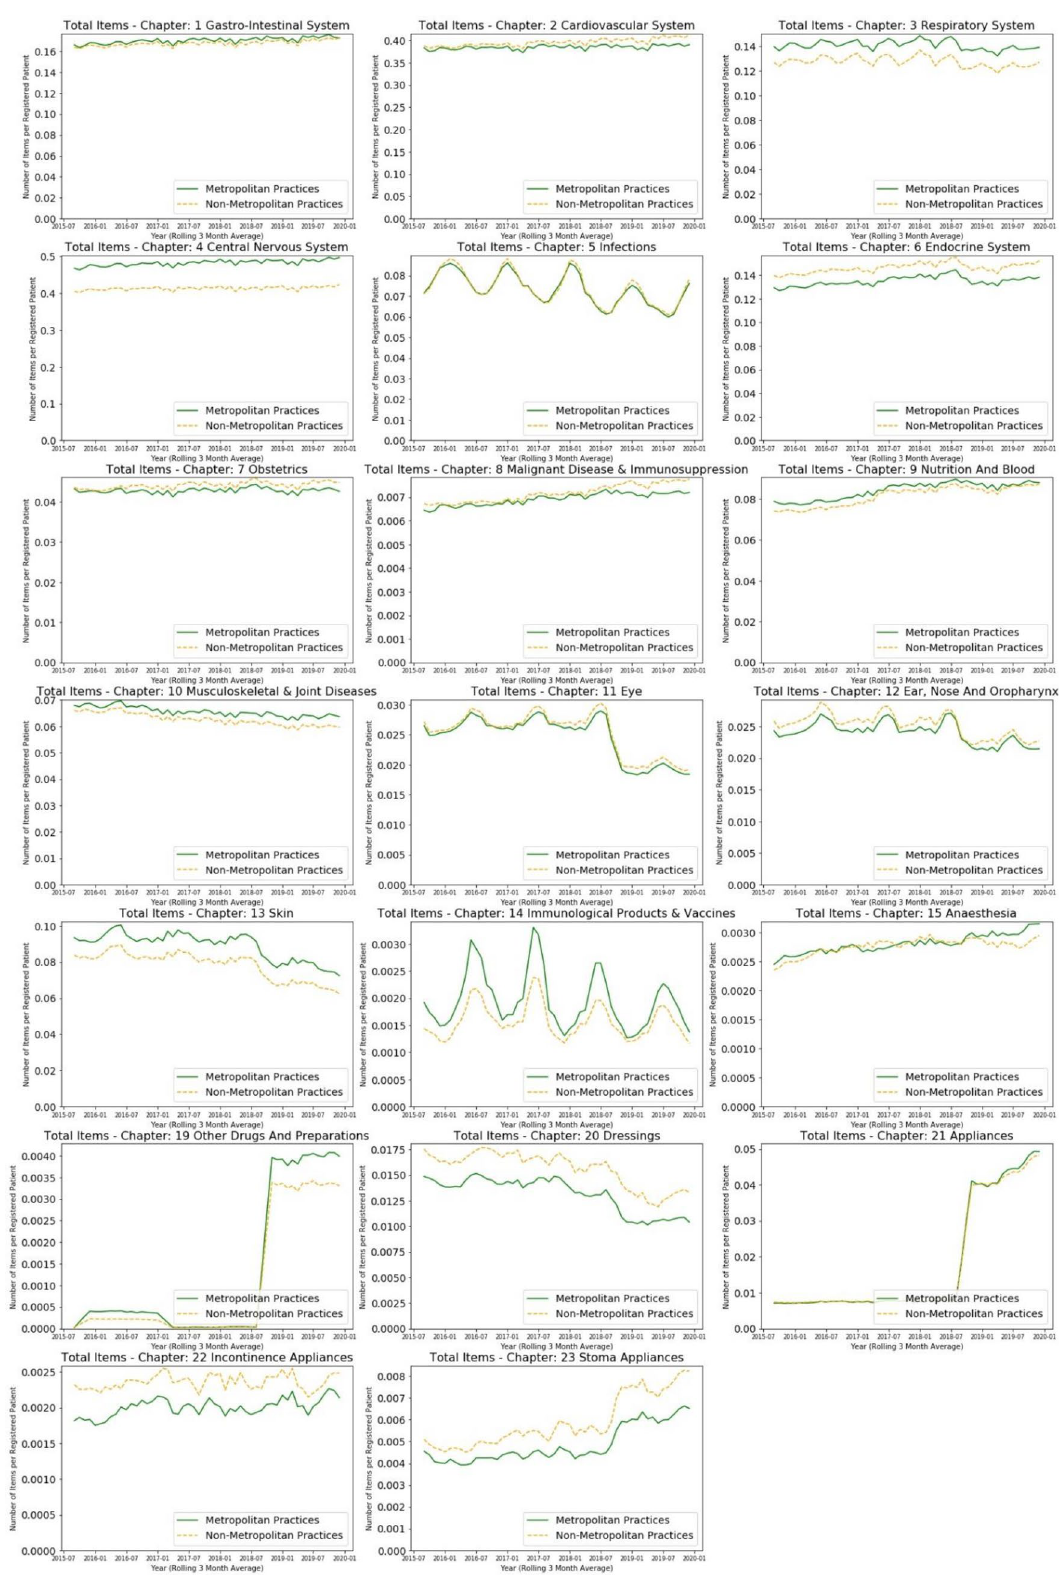
Figure 10. Total Items prescribed by cluster by BNF